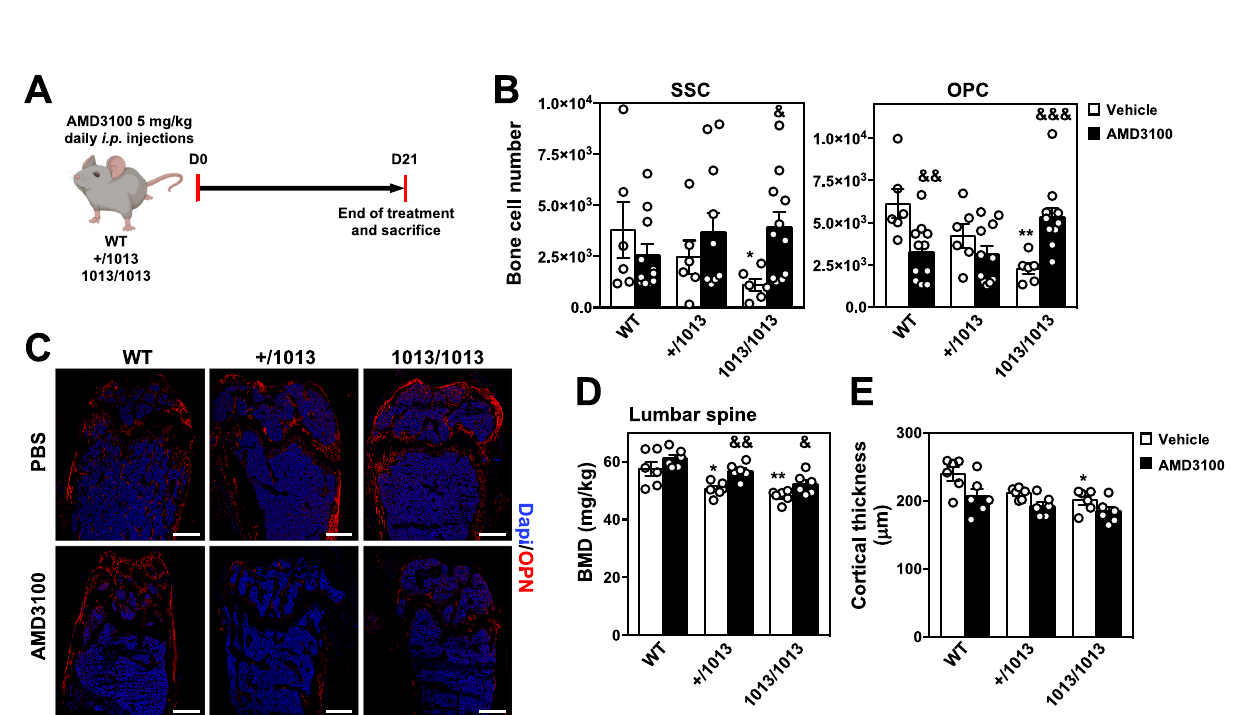
Fig. 7 | Normalization of Cxcr4 signaling rescues the osteogenic properties of Cxcr4 1013 -bearing mouse skeletal cells. A Schematic diagram for daily AMD3100 intra-peritoneal ( i.p .) injection for 21 days in WT and mutant mice. Mouse icons were created using the Biorender software (Biorender.com, agreement number: VX255VH9TZ). B Absolutenumbersoftheindicatedstromacellsubsetsfrombone fractions of WT and mutant mice determined by fl ow cytometry. Data